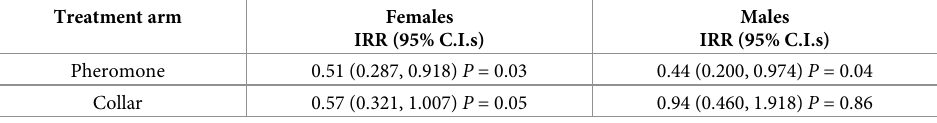
Table 5. Intervention effects 1 on household numbers of male and female Lu . longipalpis sand flies captured across 3 CDC lights traps per house. Treatment arm